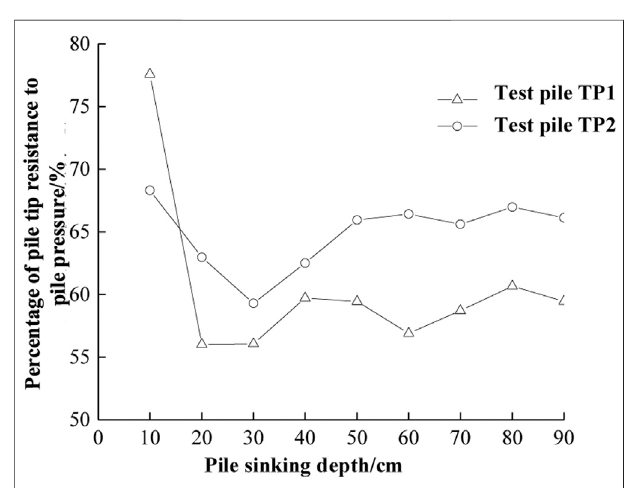
FIGURE 9 | Pile end resistance as a percentage of the pile